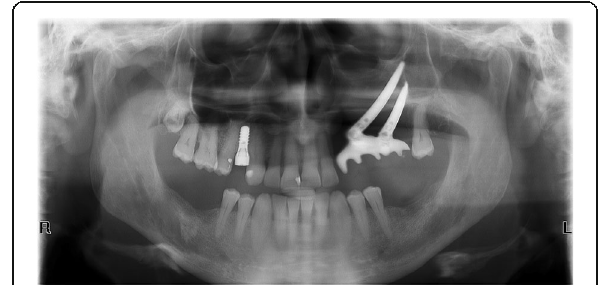
Fig. 3 Pt no. 1. CT scan reconstruction showing zygomatic implant placement after maxillectomy